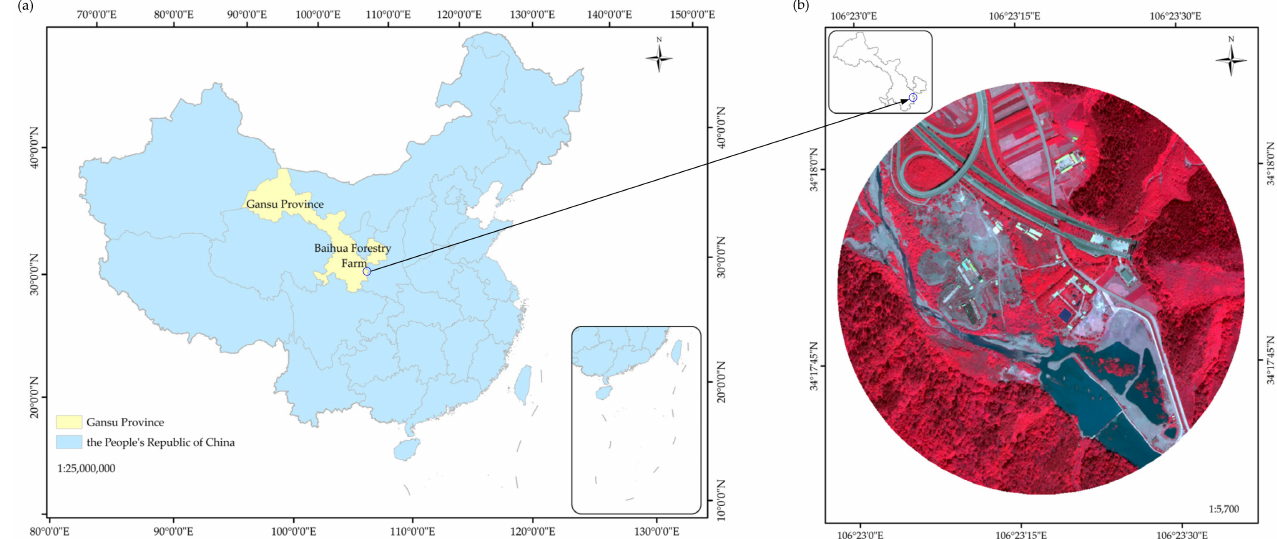
Figure 1. ( a ) Location of the study area; and ( b ) WorldView-3 image of the study